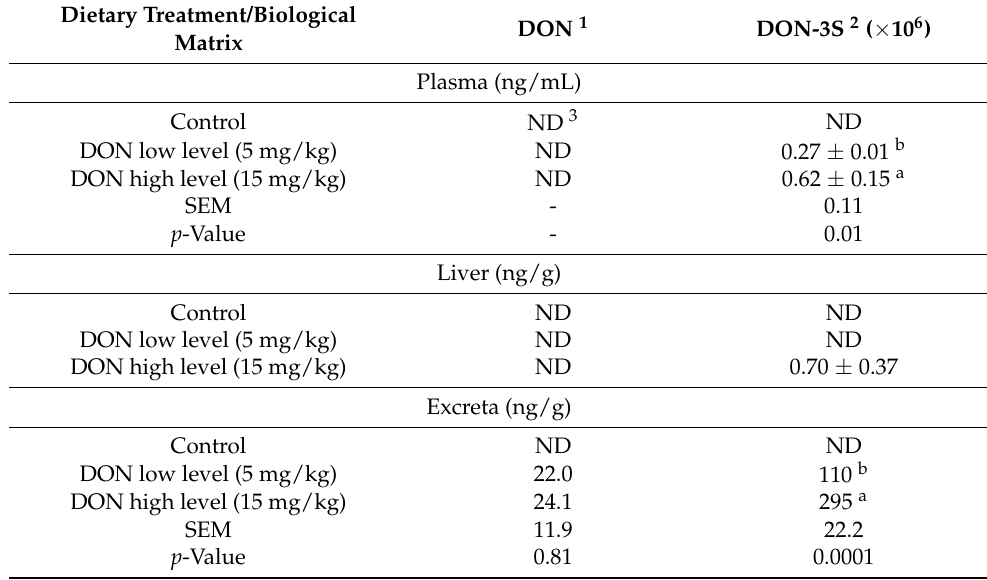
Table 4. Average concentrations of DON and DON-3S (peak area) in plasma, liver and excreta